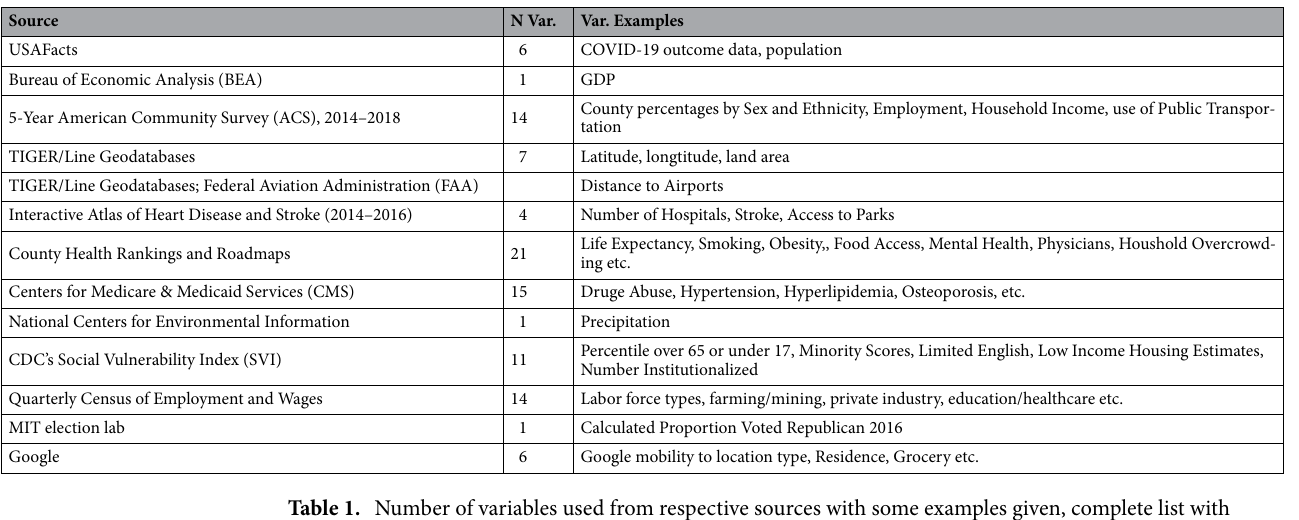
Table 1. Number of variables used from respective sources with some examples given, complete list with distributions given in supplementary